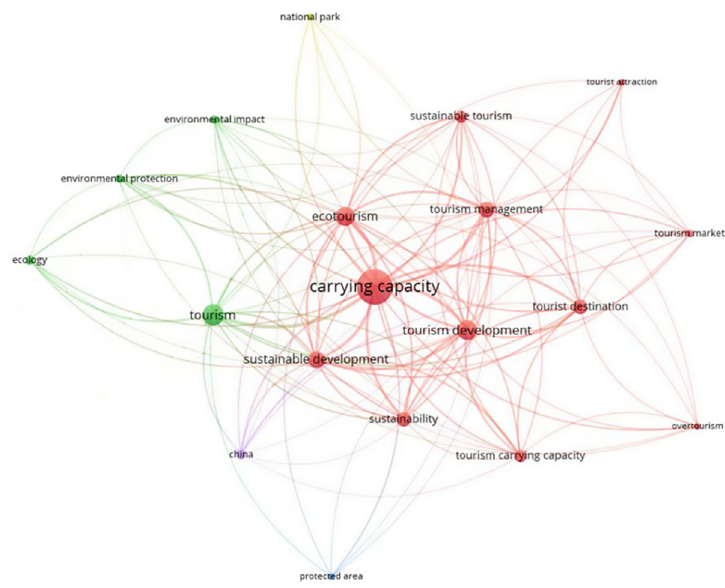
Figure 5. Overall keyword co-occurrence analysis.